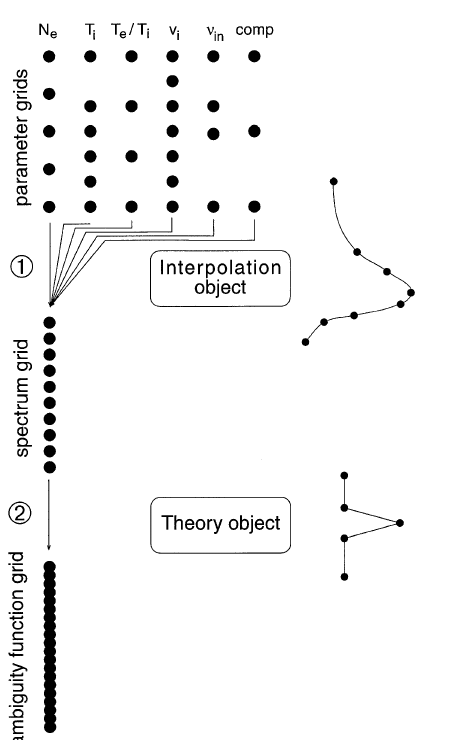
Fig. 3. Illustration of the different grids used in full-profile modeling of the ionosphere